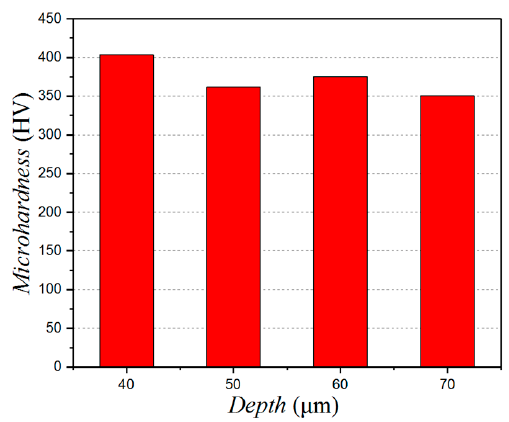
Figure 12. Influence of the micro ‐ texture depth on the surface micro ‐ hardness.